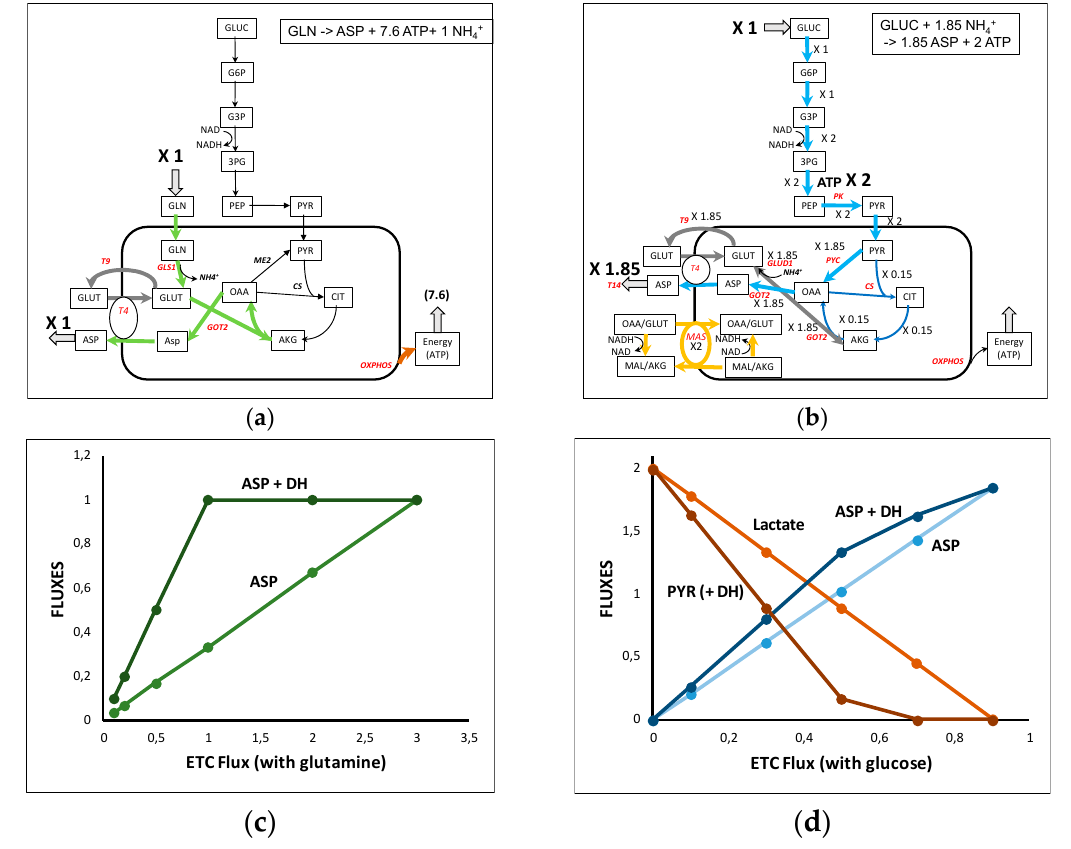
Figure 4. A simplified representation of aspartate synthesis from glutamine ( a ) and glucose ( b ). Note that in ( b ), the flux through T4 and GOT 2 can be split in a malate–aspartate shuttle (MAS) with a flux of 2 and in a 1.85 flux through T4 corresponding to aspartate output, i.e., T4 net flux is 3.85. See the complete representation of the glutamine- and glucose-derived aspartate in Figure S4a,b. ( c ): ETC inhibition (RC34 is inhibited) of aspartate synthesis from glutamine in the absence or presence of the dehydrogenase DH which reoxidizes NADHc. ( d ) ETC inhibition (RC34 is inhibited) of aspartate synthesis from glucose in the absence or presence of the dehydrogenase DH which reoxidizes NADHc. The ETC inhibition leads to lactate release, or pyruvate release in the presence of DH.